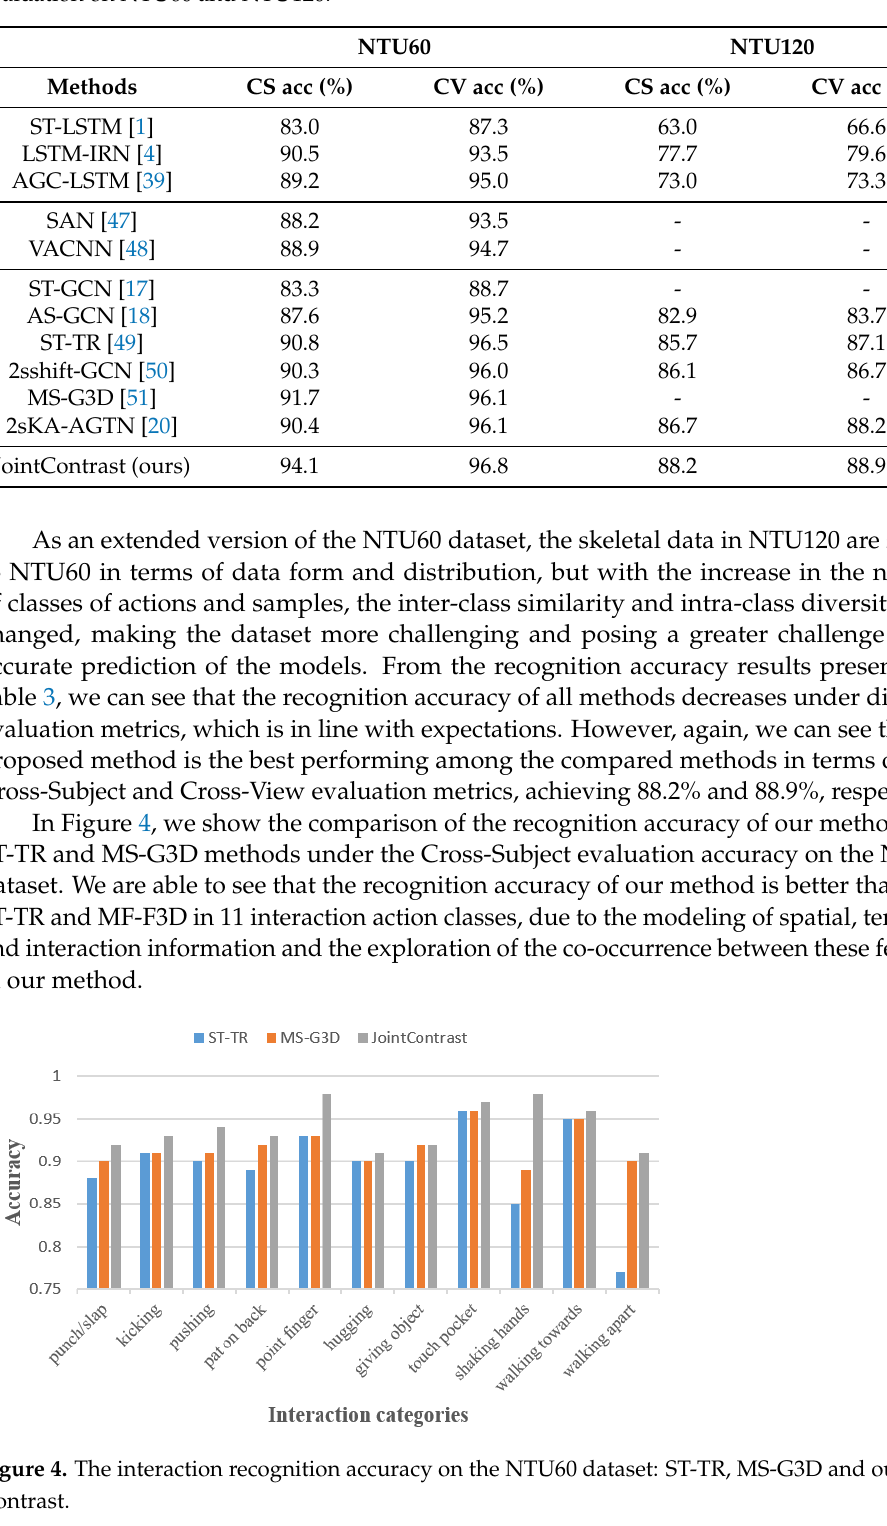
Table 3. The interaction recognition accuracy under Cross-Subject (CS) and Cross-View (CV) accuracy evaluation on NTU60 and NTU120.